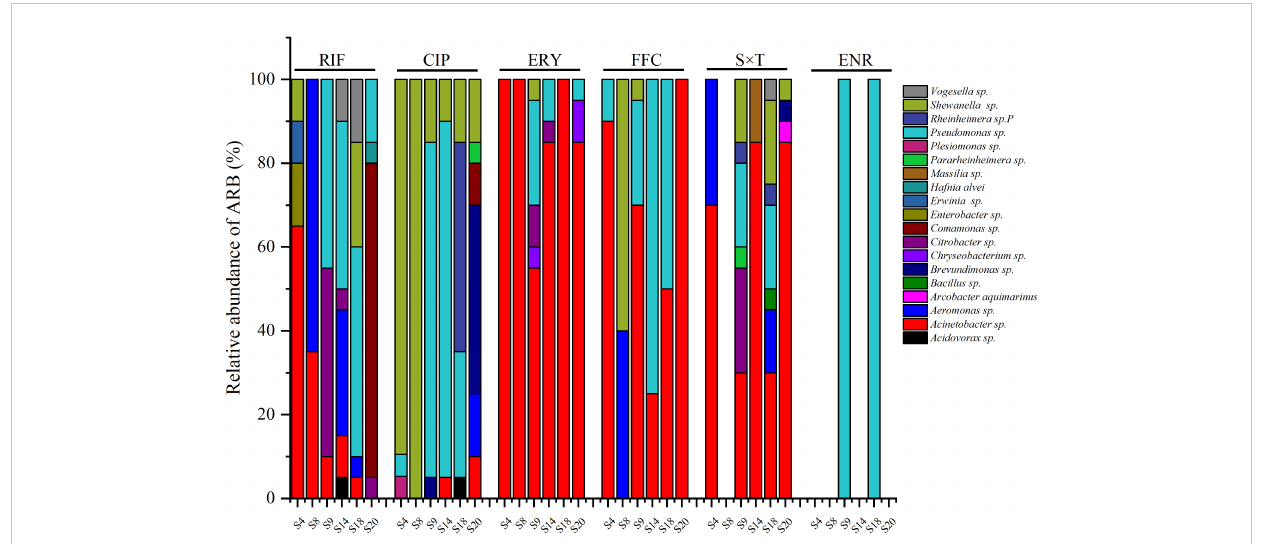
FIGURE 4 ARB resist to different antibiotics from different sea bass ponds (CIP, cipro fl oxacin; ERY, erythromycin; FFC, fl orfenicol; RIF, rifampicin; S×T, sulfamethoxazole × trimethoprim; ENR, enro fl